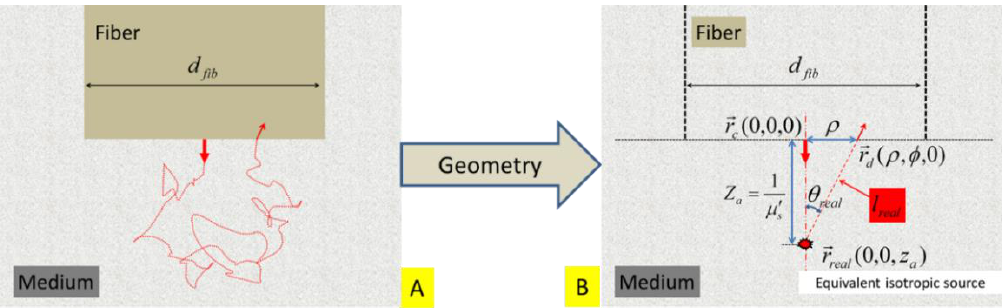
Figure 2. ( A ) Schematic of an idealized geometry for placing a fiber with a diameter of and a straight-polished tip within a turbid medium. The same fiber is used for launching light into and collecting light from the medium. A dual-point configuration approximates the light leaving and returning to the fiber. ( B ) The light that is initially directionally-launched into the medium is represented by an equivalent isotropic source that is located at ),0,0( where 1 μ a . The acute angle formed by the line of the fiber is θ real